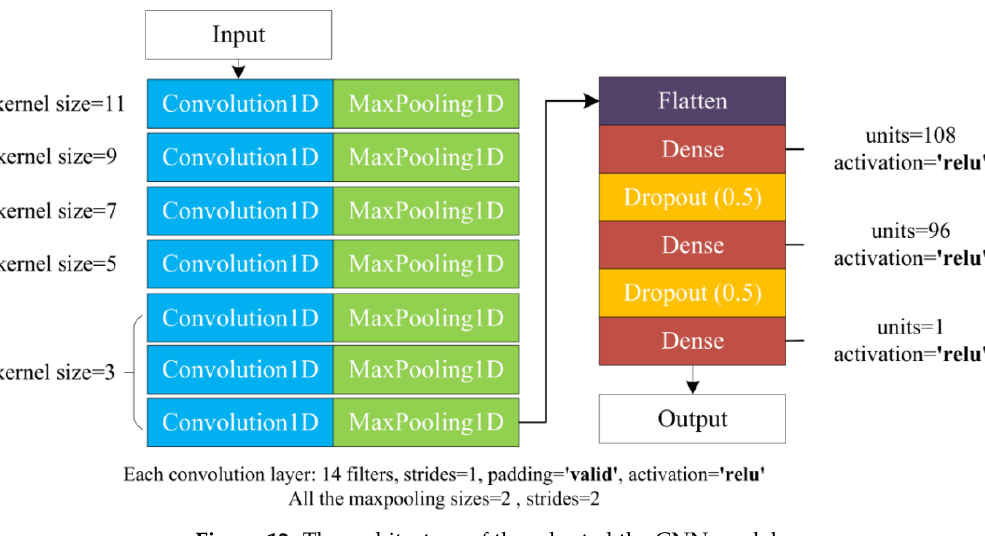
Figure 13. Loss (MAE) history of the CNN.